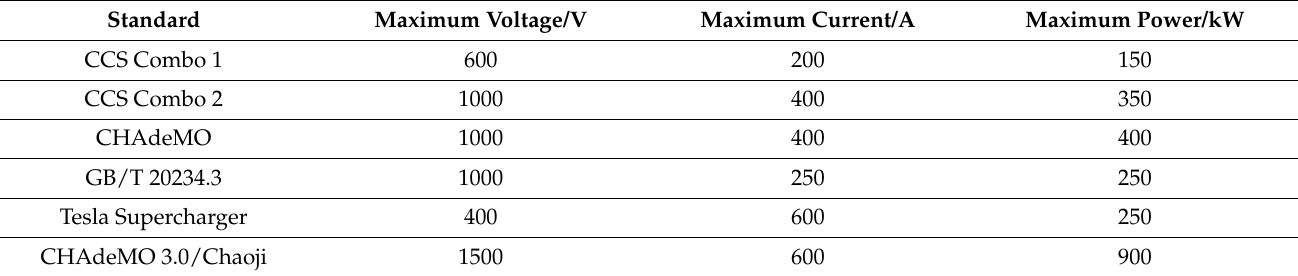
Table 3. Electrical characteristics of global high-power charging